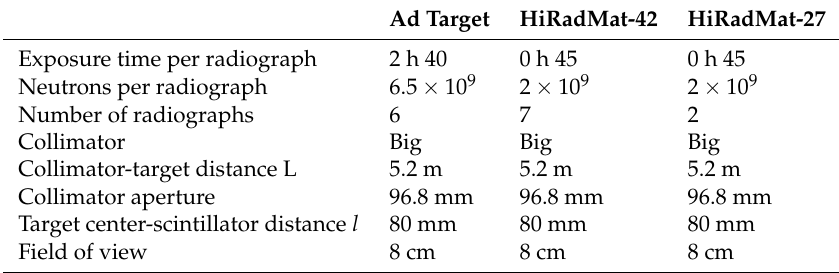
Table 2. Relevant experimental parameters for the radiographs of the AD and HiRadMat